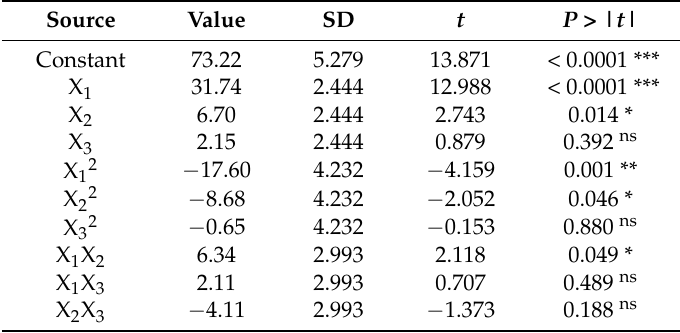
Table 3. Statistical analysis of the regression coefficients.